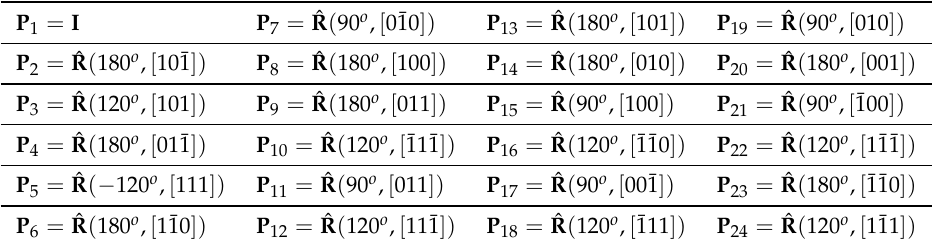
24 which map a cube onto itself. ∈ P